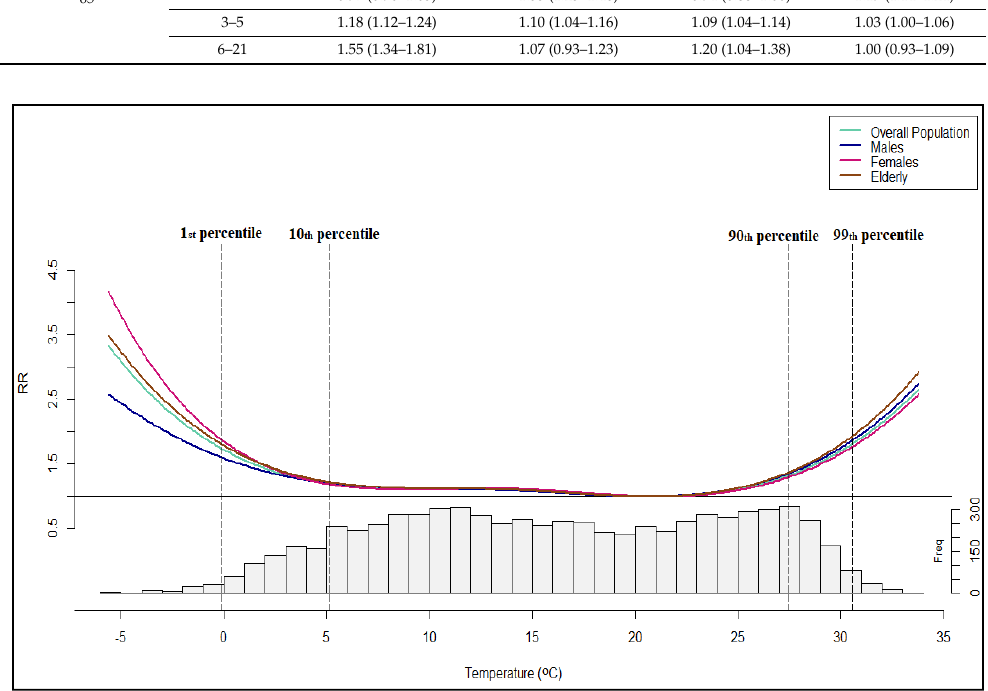
Figure 4. Lag-response curves for exposure to extreme heat (95% CI) for ( a ) the total population, ( b ) the elderly, ( c ) males, and ( d ) females. ΜΜΤ was observed at 4.7 ° C above the average mean daily temperature, at the 65th percentile of the temperature distribution (20.9 °C) for the overall population and the elderly, at the 64th percentile (20.5 °C) for males and the 67th percentile (21.4 °C) for females (Table 2). In all cases, the cumulative exposure-response relationship between mean temperature and car- diorespiratory mortality was depicted by a U-shaped curve, where the lowest extrema corresponded to MMT (Figure 5). A closer look at Figure 5 reveals significant gender dif- ferences in the mortality risk for temperatures below the 1st percentile, where it is obvious that females are the most susceptible group of the population to extreme cold, followed by the elderly. However, such extreme temperatures rarely occur in EMT, as they com- prise only 1.08% of the total number of days (Figure 5, Table S2).